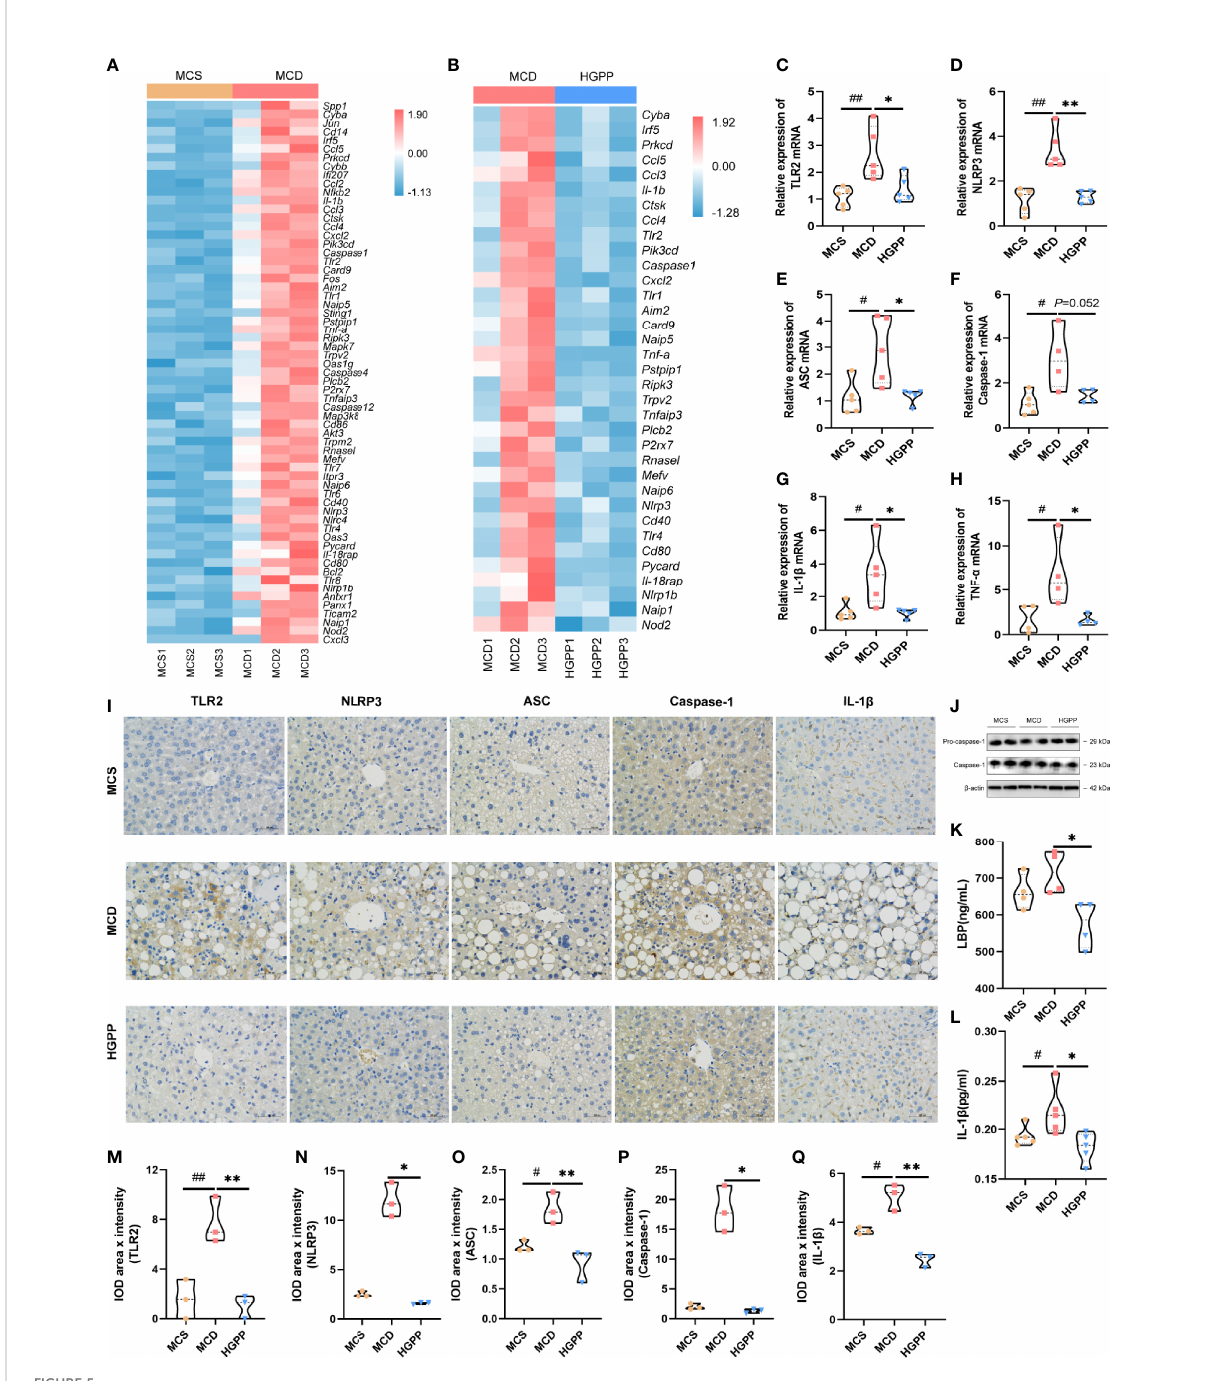
FIGURE 5 The potential mechanism of the HGPP at the molecular level. (A) Heatmap of differential gene expression in TLR and NLR signaling pathways between the MCD and MCS groups. (B) Heatmap of differential gene expression in TLR and NLR signaling pathways between the MCD and HGPP groups. (C – H) The relative TLR2, NLRP3, ASC, Caspase-1, IL-1b, and TNF- a mRNA expression levels (n = 4-5). (I) Immunohistochemical assay of TLR2, NLRP3, ASC, Caspase-1, and IL-1 b in hepatic tissue (magni fi cation, ×400, 100 m m) (n = 3). (J) Pro-caspase-1 and Caspase-1 expression was evaluated by Western blotting in liver samples. (K) The level of LBP in blood serum was tested by enzyme-linked immunosorbent assay (ELISA) (n = 4). (L) The level of IL-1 b in blood serum was tested by ELISA (n = 5). (M – Q) Immunohistochemical images were quanti fi ed for integrated optical density (IOD, Area × Intensity) (n = 3). The 2 − △△ Ct method was used to analyze relative gene expression levels. Data are expressed as median and interquartile range (IQR). * P <0.05 and ** P <0.01 vs. the MCD group; # P <0.05 and ## P < 0.01 vs. the MCS group. One-way ANOVA test followed by a least signi fi cant difference (LSD) (C, K – M, O, Q) ; Kruskal – Wallis test (D – H, N, P)